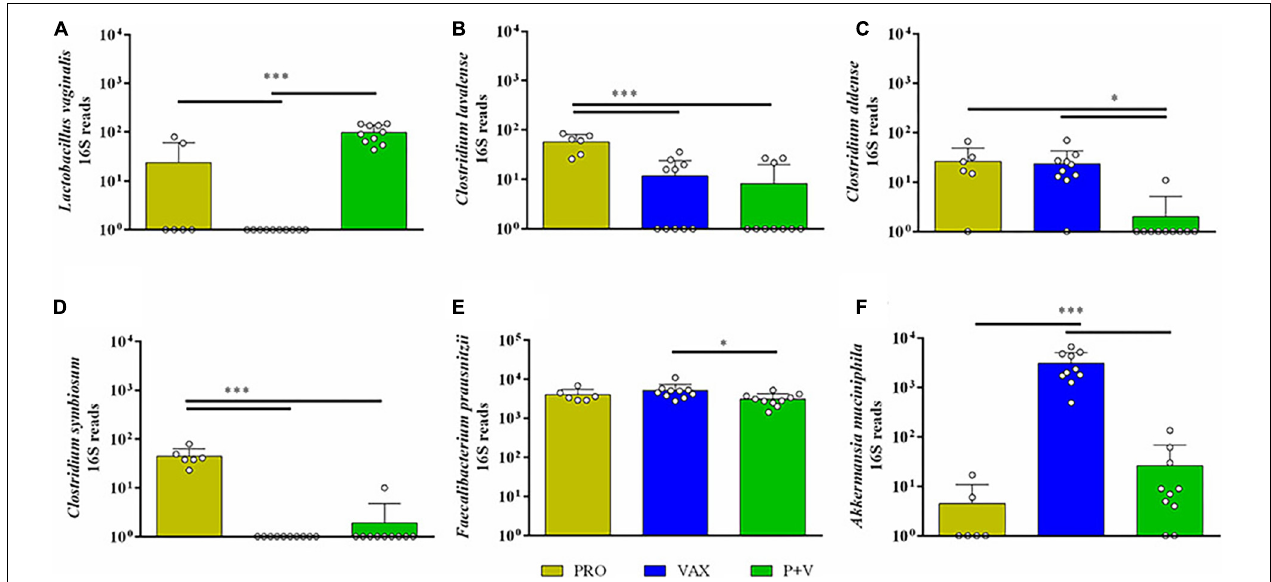
FIGURE 6 | Bacterial abundances of bacterial species influenced by treatment group. 16S reads for (A) Lactobacillus vaginalis , (B) Clostridium lavalense , (C) Clostridium aldense , (D) Clostridium symbiosum , (E) Faecalibacterium prausnitzii , and (F) Akkermansia muciniphila were generated by QIIME2 software, and figures were developed on GraphPad. Yellow, PRO; blue, VAX; green, P+V. ∗ P < 0.05; ∗∗∗ P < 0.001.